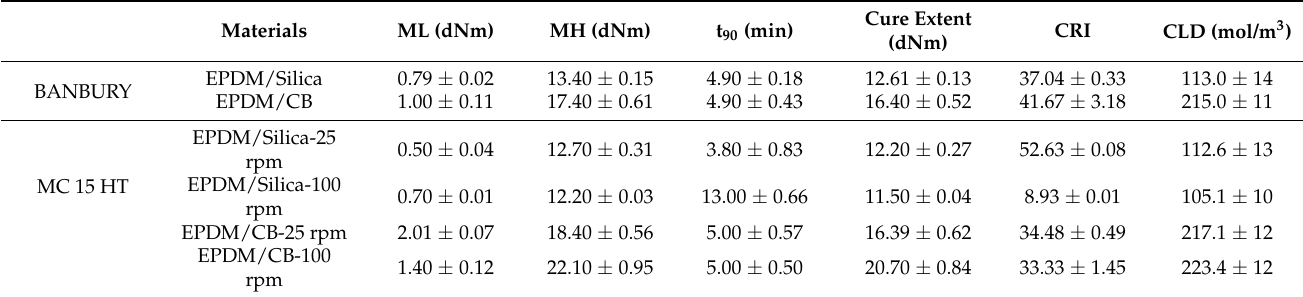
Figure 10. Rheometer curves of the composites ( a ) EPDM/CB prepared in Banbury and MC 15 HT, ( b ) EPDM/Silica, prepared in Banbury and MC 15 HT. Table 4. Data obtained from MDR for the samples prepared in Banbury and MC 15